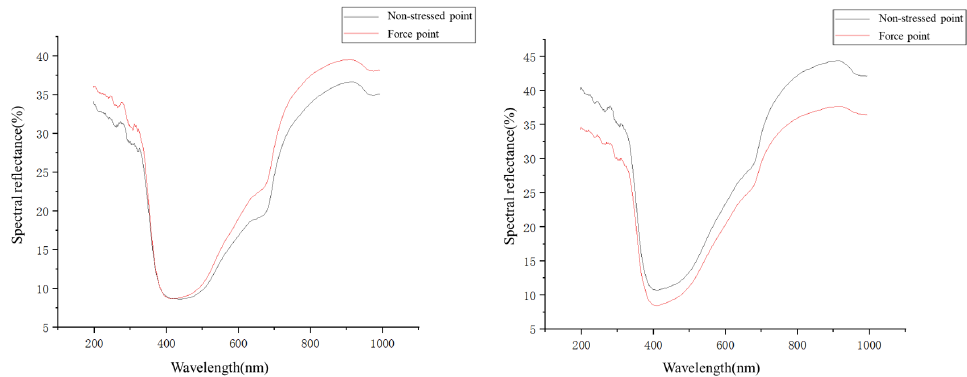
Figure 11. Kiwifruit spectrum test statistics.